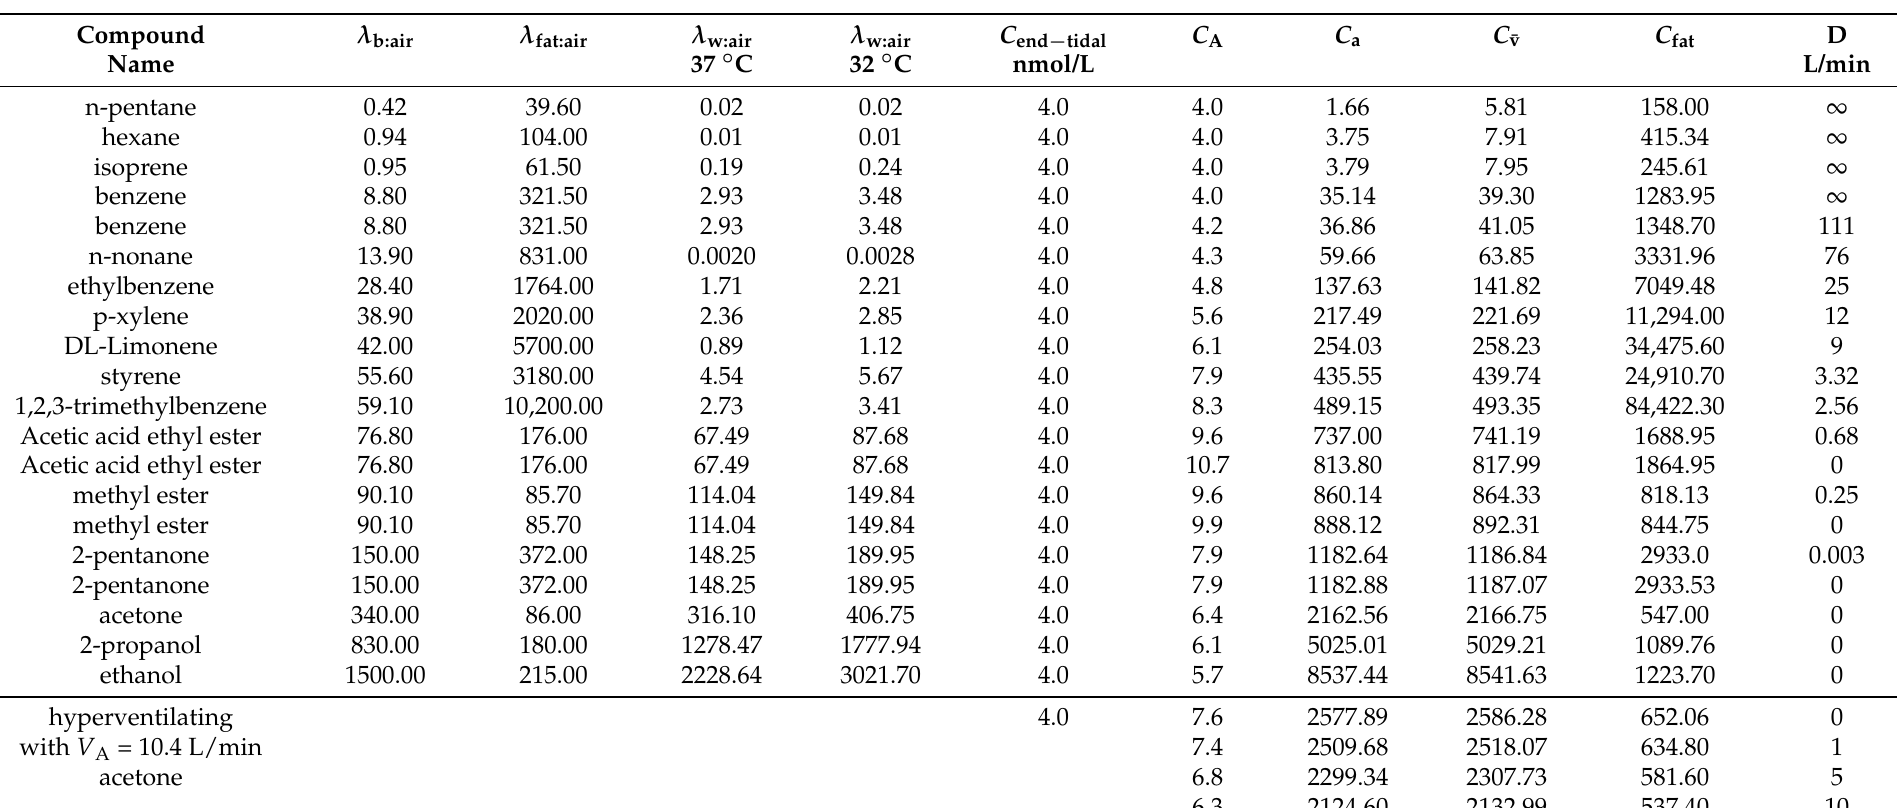
Table 1. Estimated concentrations of 16 VOCs in alveolar air ( C A ), arterial blood( C a ), venous blood ( C ¯v ), and fat tissue ( C fat ) for the end-tidal levels of 4 nmol/L (100 ppb). Partition coefficient values can be found in Sander